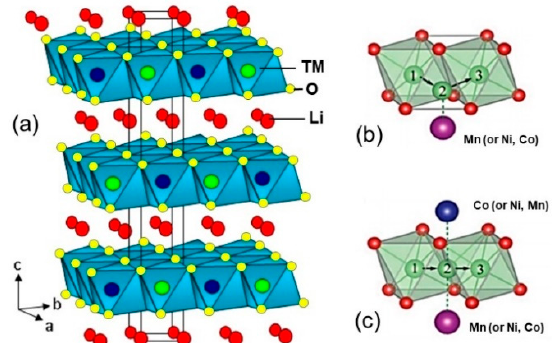
Figure 2. ( a ) Layered structure of NCM compound. Colors of atoms are green (Li), red (O), and silver / purple / blue are Ni, Mn, Co transition-metal cations, respectively. ( b ) Tetrahedral site pathway. ( c ) Oxygen dumbbell pathway for Li + ions.